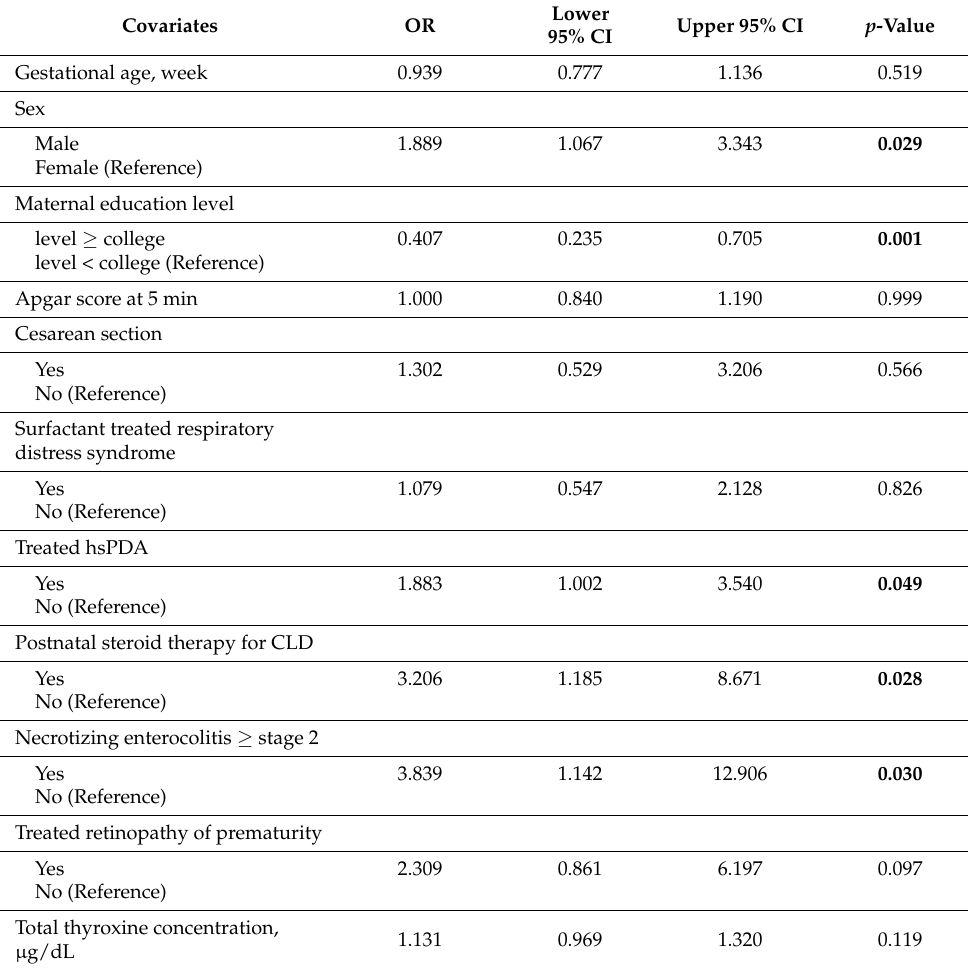
Table 3. Dependence of neurodevelopmental impairment * on clinical variables: a multivariate